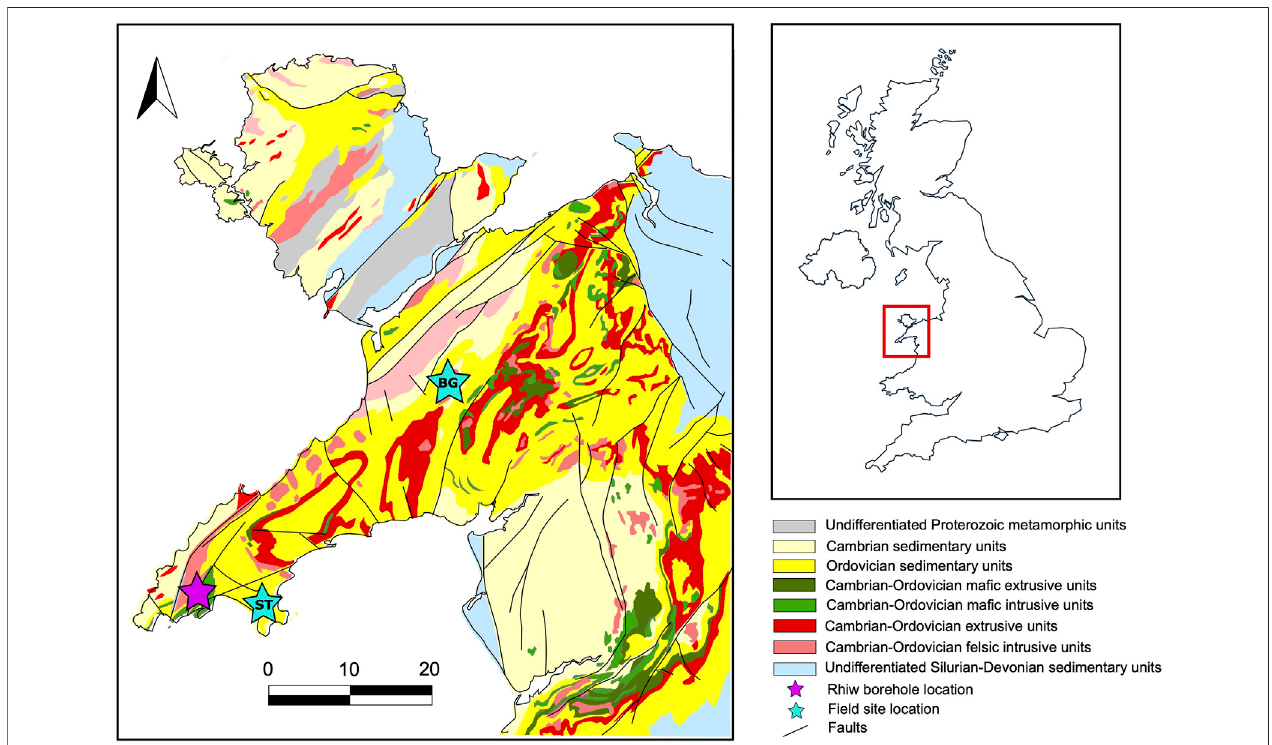
FIGURE 2 | Simpli fi ed geological map of North Wales, United Kingdom. BG (cid:1) Betws Garmon; ST (cid:1) St. Tudwal ’ s Peninsula; R (cid:1) Rhiw. From British Geological Survey materials © UKRI [2018].